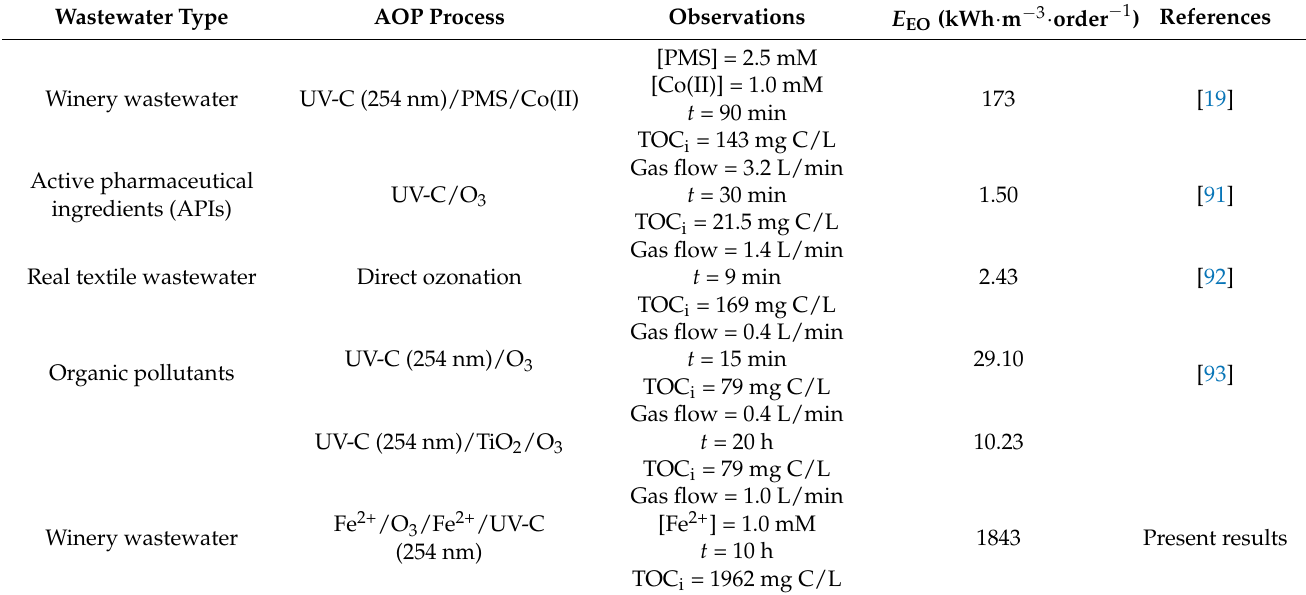
Table 7. Reported values of electric energy per order ( E EO ) in ozonation